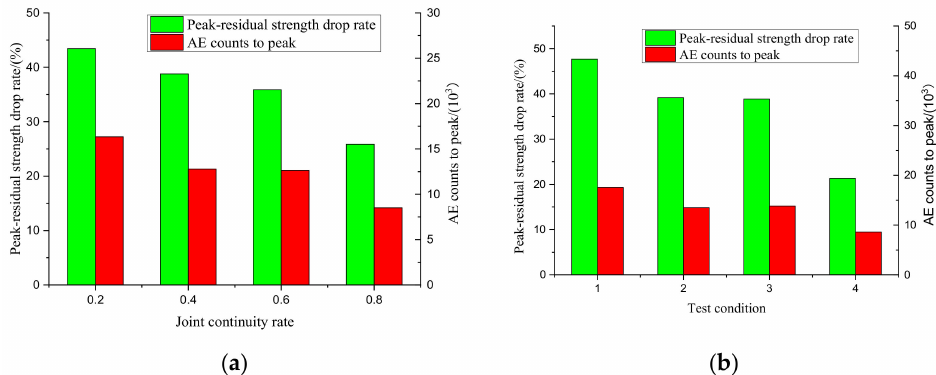
Figure 18. Relationship between the peak-residual strength drop rate and AE counts. ( a ) Scheme I, ( b ) Scheme II.